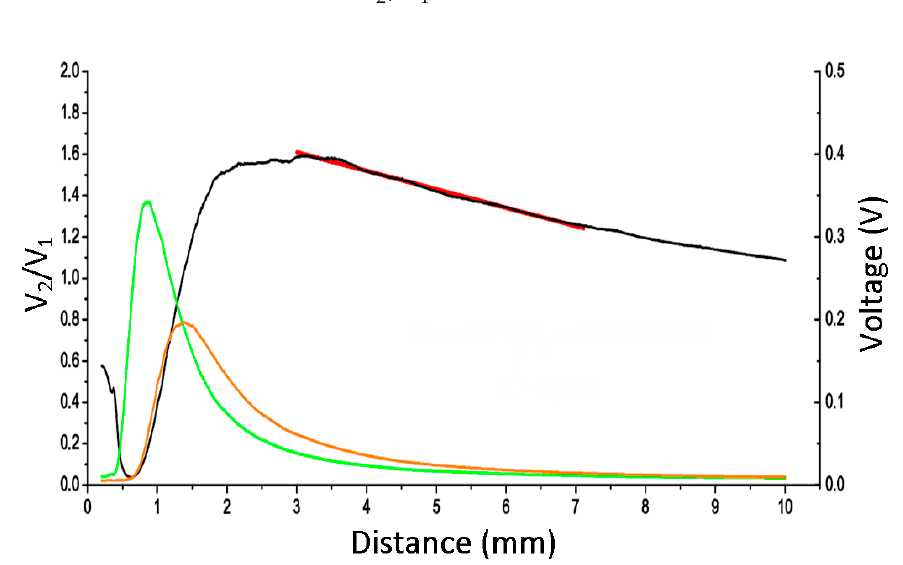
Figure 6. Calibration curve for the optic sensor.